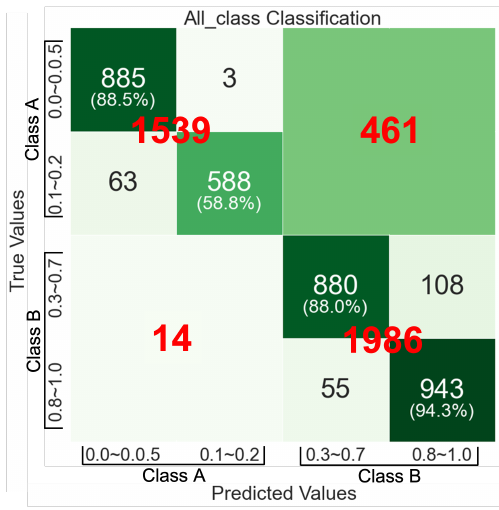
Figure 21. Overall accuracy report of 4-Class VA classifier based on our ensemble